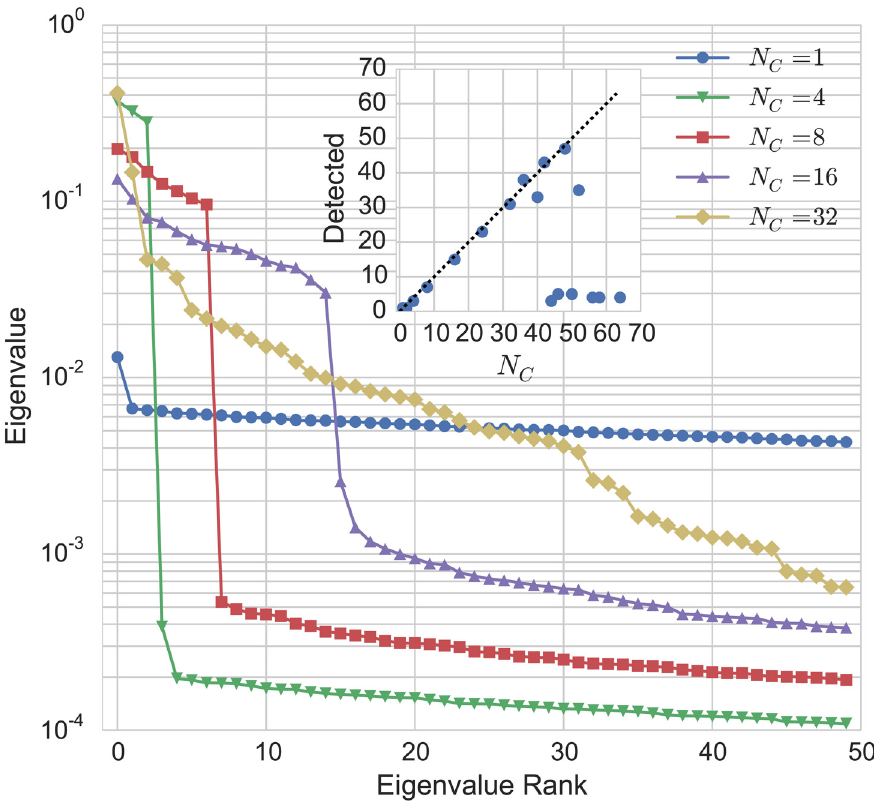
identity and eigenvalues corresponding to the fluctuations. As the number of clusters increases, the gap closes and it becomes more difficult to detect the structure of the population. Inset: Number of clusters detected by the algorithm versus actual number of